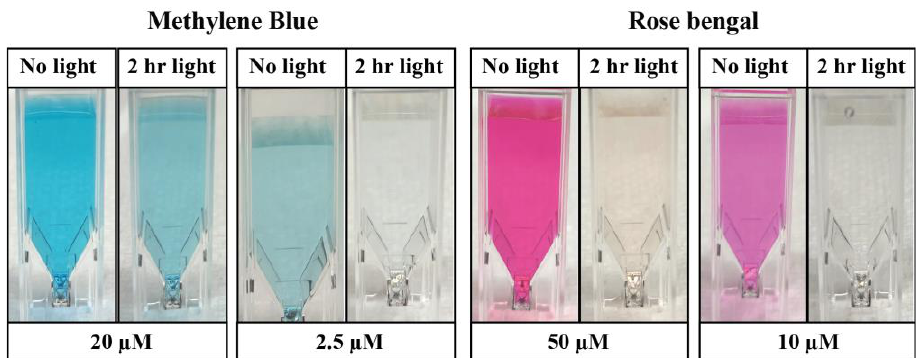
Figure 8. Photosensitive insecticides are broken down by photodegradation. Images of various